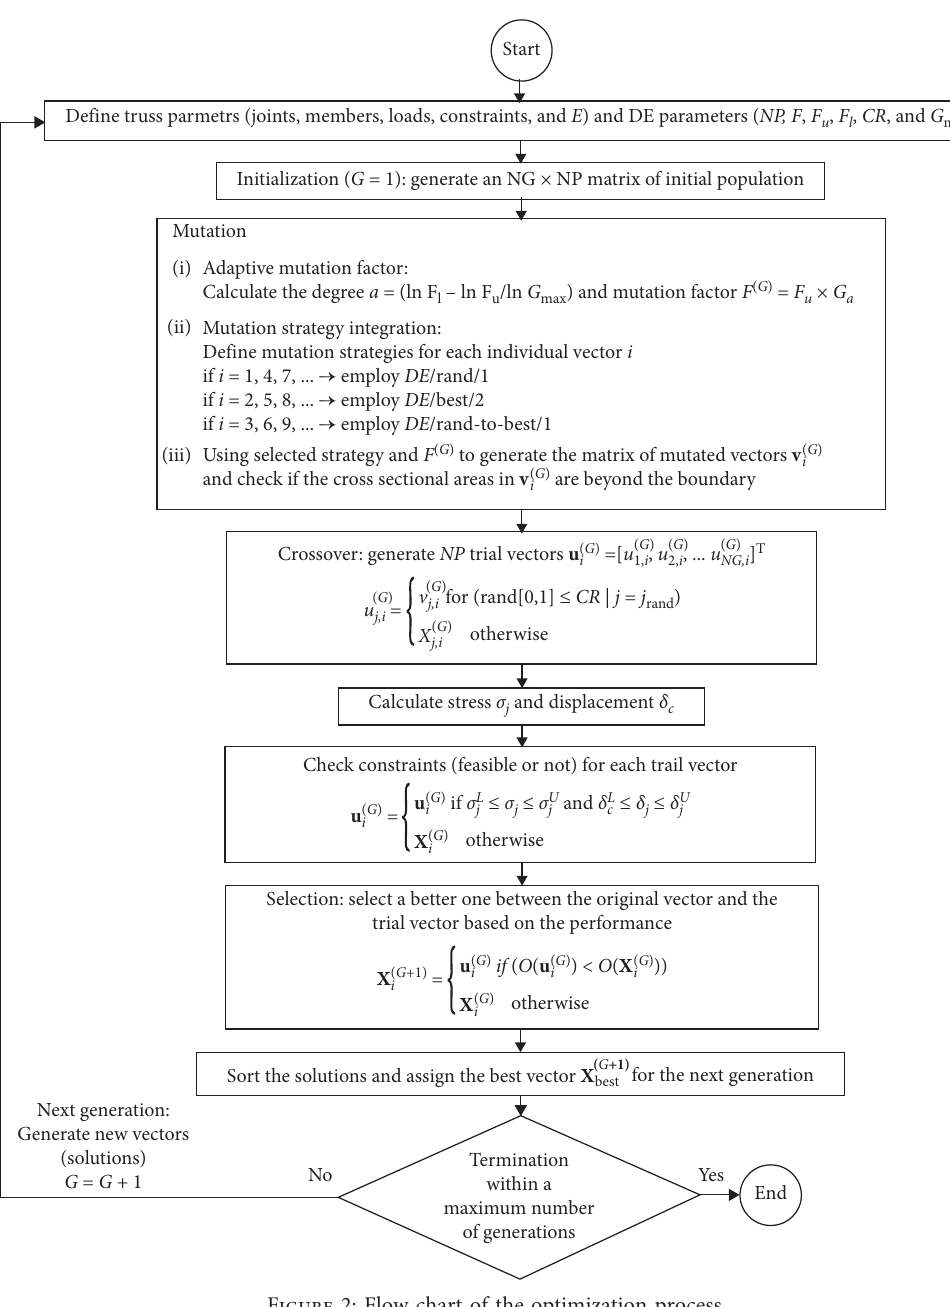
Figure 2: Flow chart of the optimization